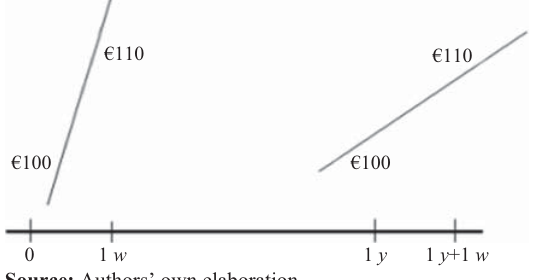
Figure 3. Preference